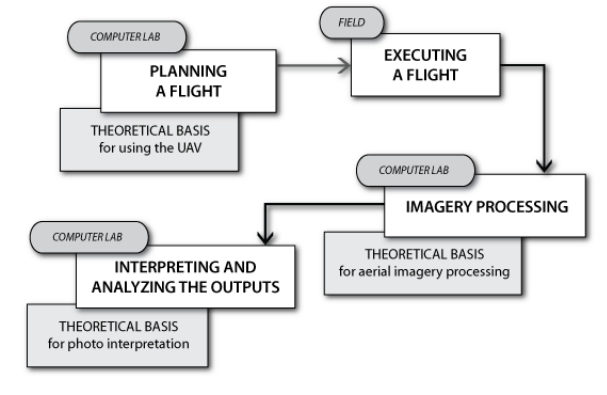
Figure 1. Schematic overview of teaching program - stages of learning how to use the UAV as a research tool The comprehensive approach to the subject requires a multi-step process of knowledge acquisition. The lesson units (45-minutes long) have been grouped into blocks based on the topic and time